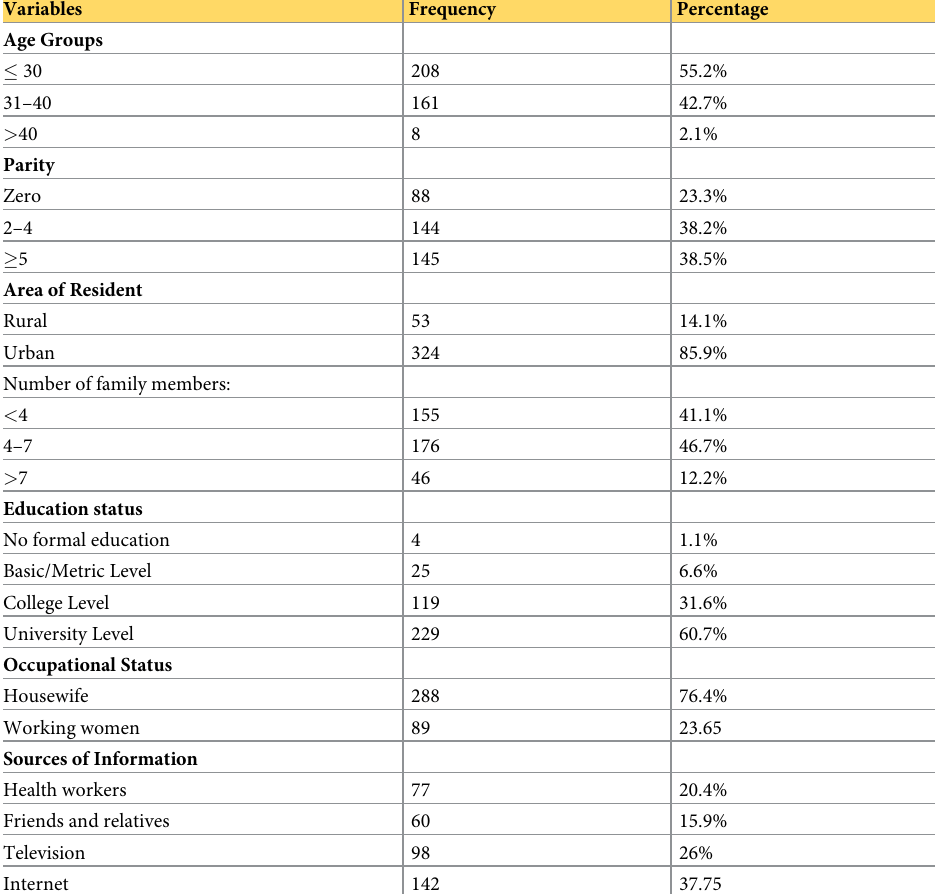
Table 1. Characteristics of pregnant women [n =